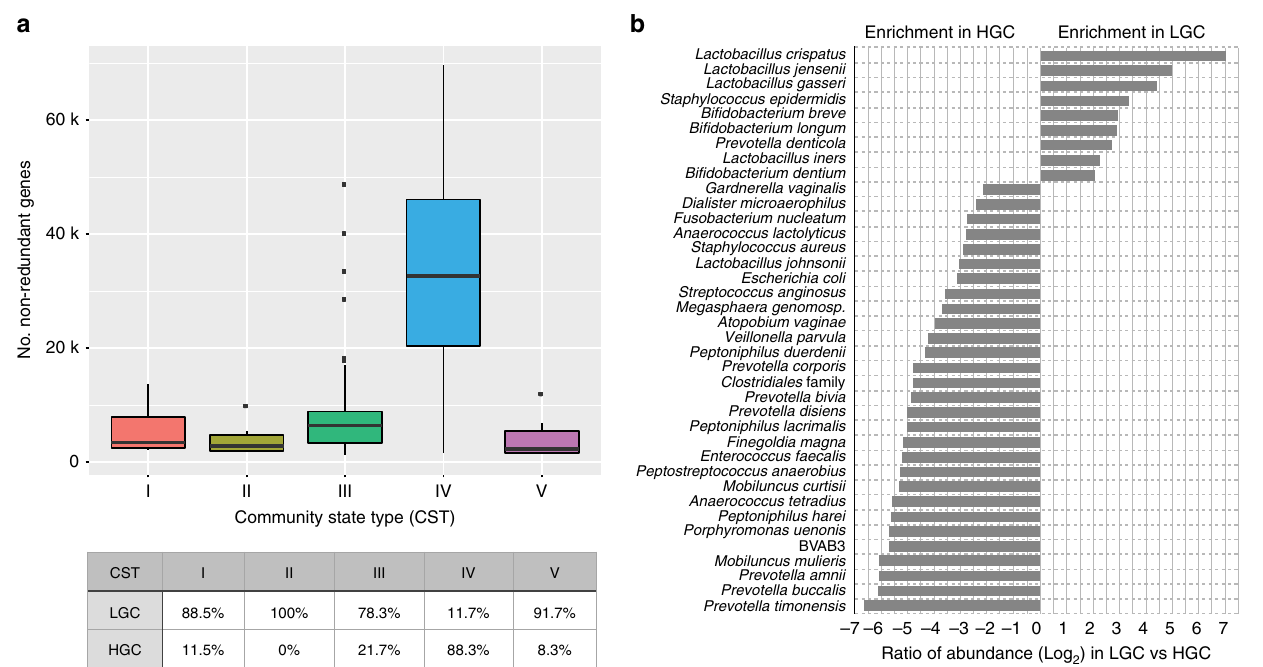
Fig. 4 a Boxplot of the number non-redundant genes in samples of different Community State Types (CSTs). Boxes represent the interquartile ranges and lines represent the median values. CSTs were de fi ned as previously according to the composition and structure of the microbial community 21 . Table below boxplot contains percentage of samples in each of the CSTs strati fi ed by high gene count (HGC) or low gene count (LGC), in which HGC has >10,000 non- redundant genes and LGC has <10,000 non-redundant genes. b Plot of the log 2 transformed ratio of the gene of a species being in one gene count category over the other across the 264 vaginal metagenomes, only the species with more than four times more abundant in a category (either HGC or LGC) are shown. The species with at least 0.1% abundance and at least 100 genes in either HGC or LGC groups. Plotted are interquartile ranges (IQRs, boxes), medians (line in box), and mean (red